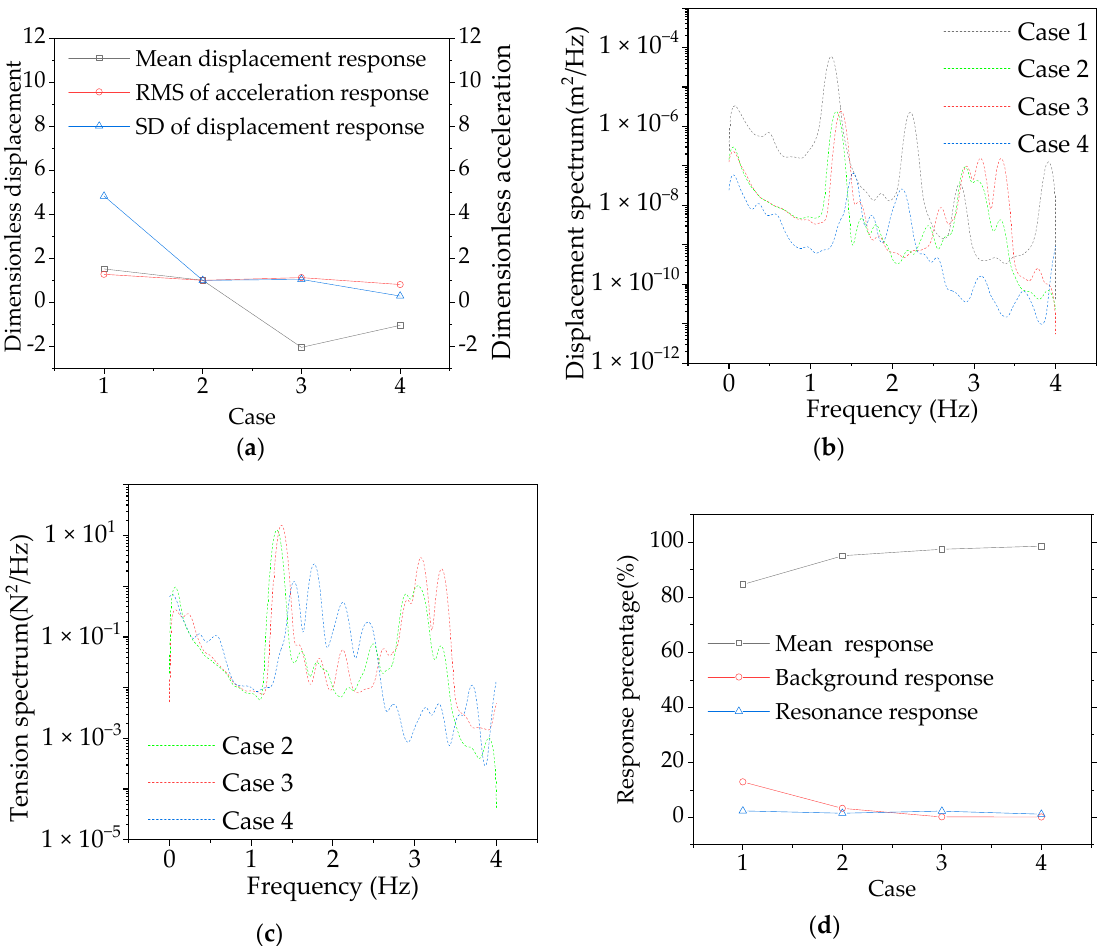
Figure 15. Parametric analysis of stayed cables layout cases. ( a ) Wind-induced vibration response, ( b ) Bridge displacement spectrum, ( c ) Stayed cables tension spectrum, ( d ) Response ratio.